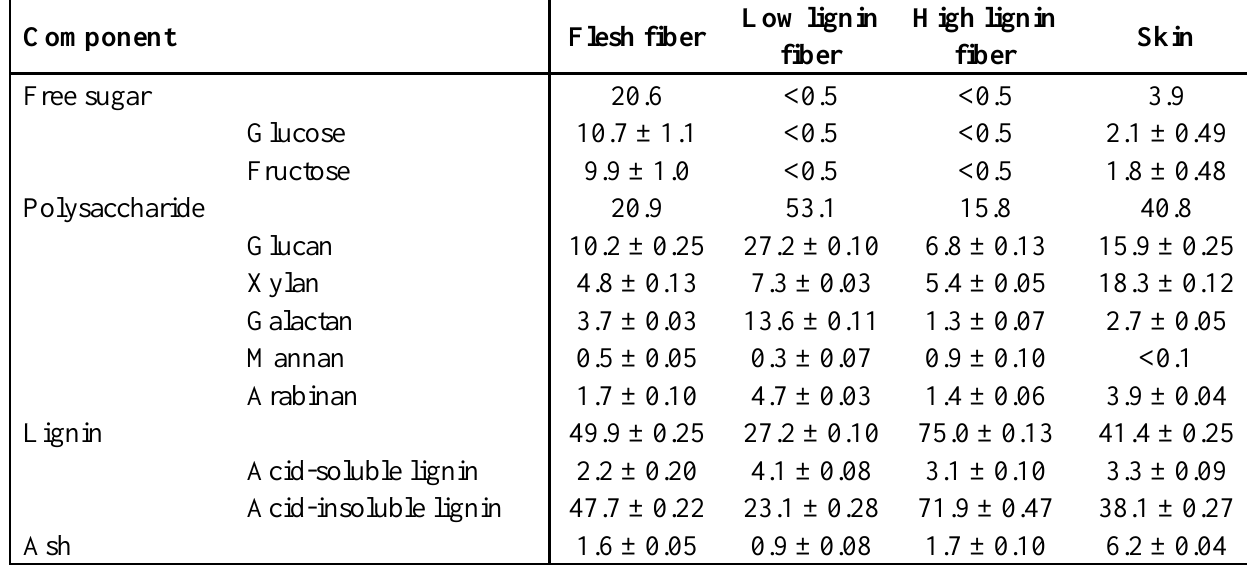
Table 2. Composition of hot water-insoluble flesh fiber and skin part of palm date as well as low lignin and high lignin fibers separated from palm date